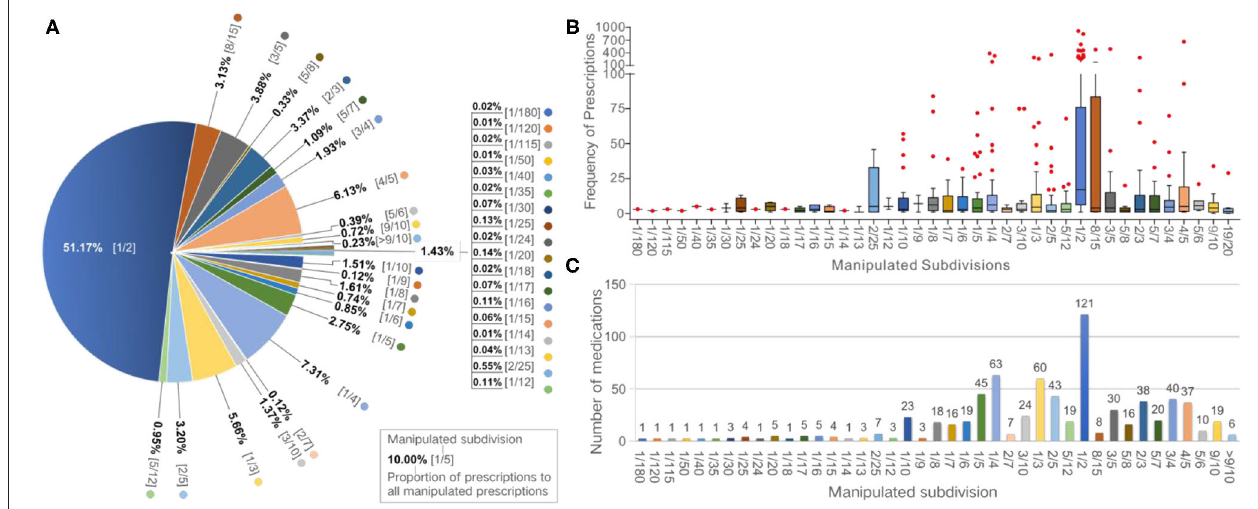
FIGURE 1 | Frequencies of manipulated prescriptions and medications according to subdivisions. (A) Pie chart showing the proportion of manipulated prescriptions for each subdivision. (B) Box plot showing the frequency of manipulated prescriptions of each medication according to subdivisions. (C) Bar graph showing the numbers of manipulated medications according to subdivisions.